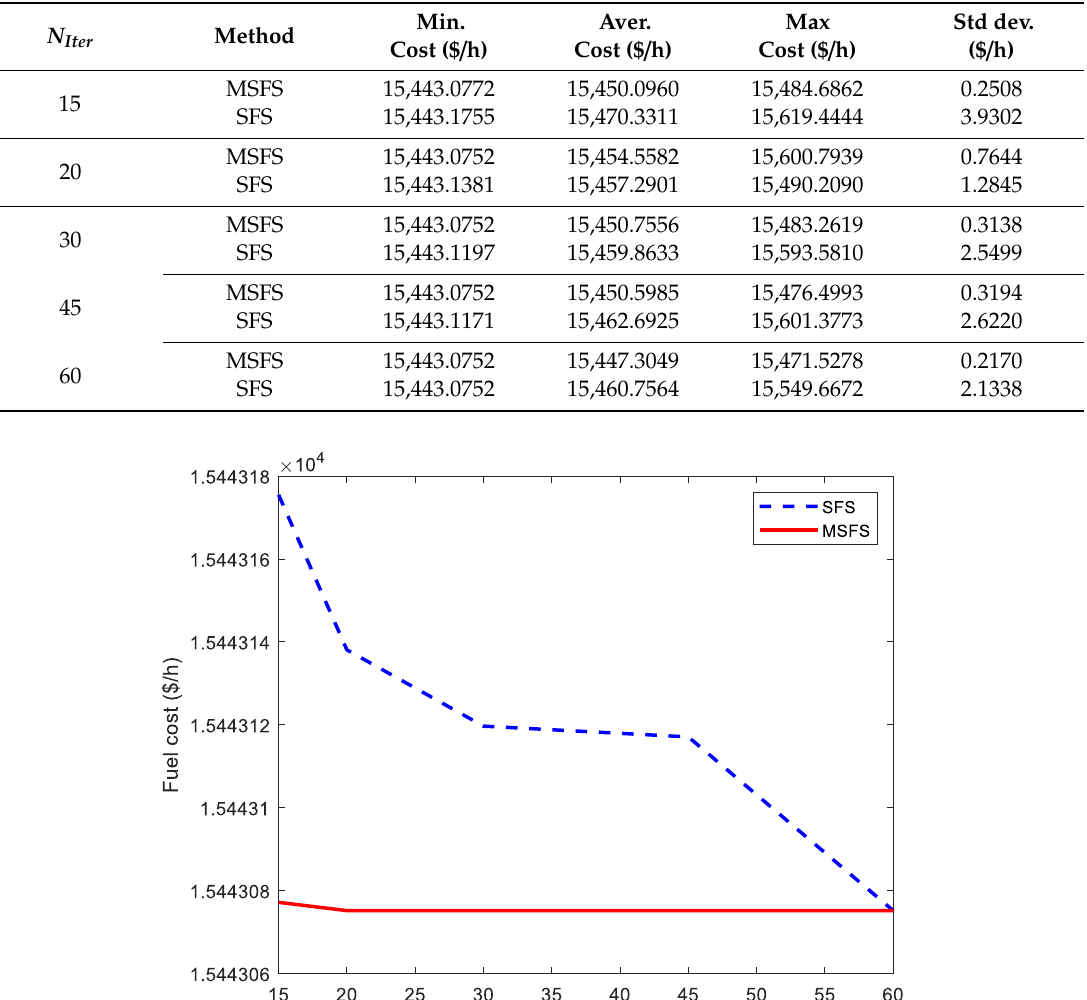
Table 3. Results obtained by MSFS and stochastic fractal search (SFS) methods for case 6.